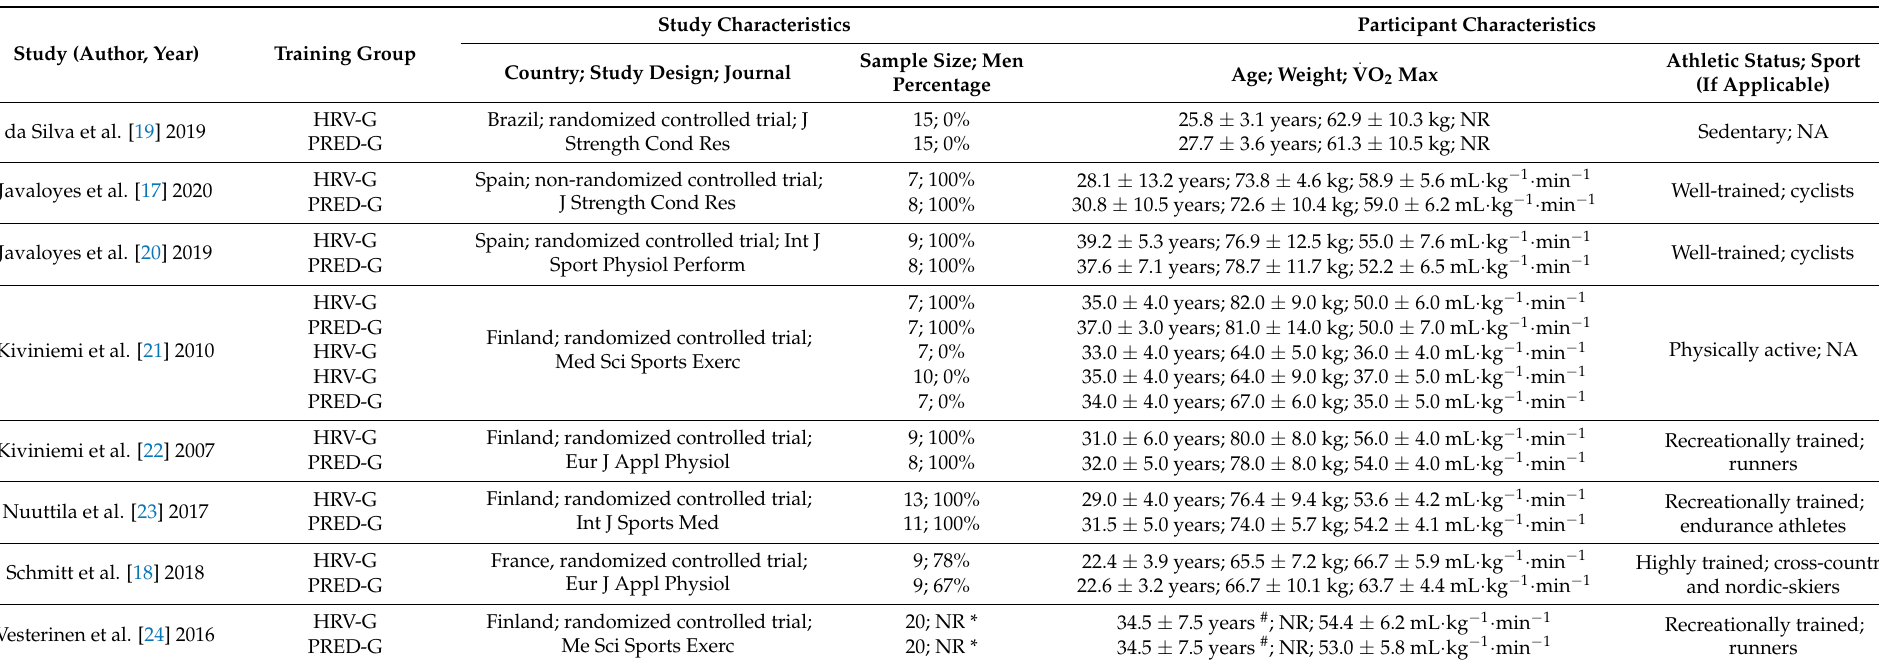
Table 1. Study and participant